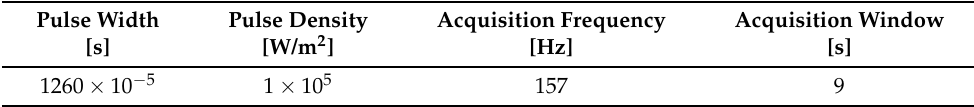
Table 2. Parameters used to adjust the simulated PT experiment. Adapted with permission from [27] © The Optical Society.